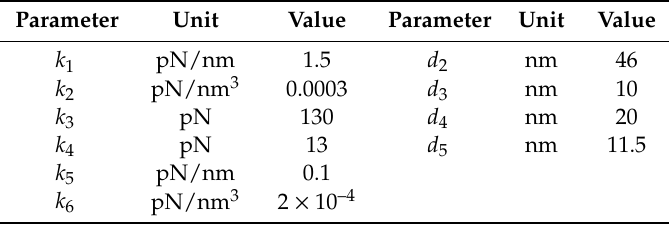
Figure 2. ( A ) Force–extension comparison of a single fibrinogen molecule from molecular dynamics (MD) simulation data [7] and from our nonlinear model. ( B ) Force–extension curve used to simulate the γ – γ interaction and knob–hole (A–a) interactions and their detachment. Table 1. Parameters and corresponding values used in this study